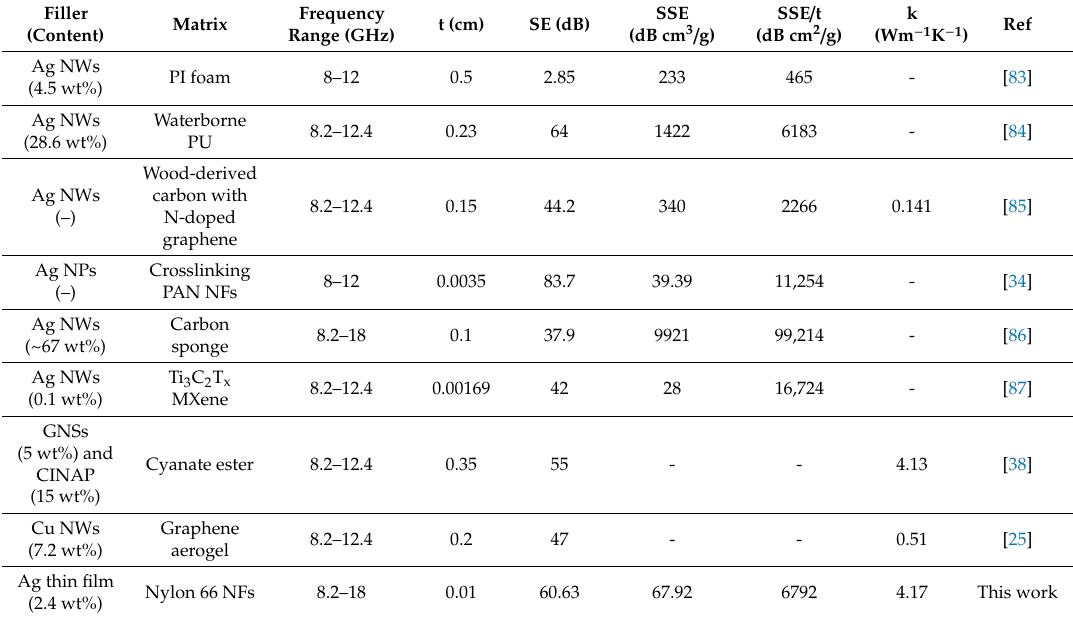
Table 2. Comparison of EMI shielding at X and / or Ku-bands and thermal performance of E-50 with the reported composites. The abbreviations, t and k, are the thickness and the thermal conductivity of the composites. Notably, the highest SE values at the specific frequency range were